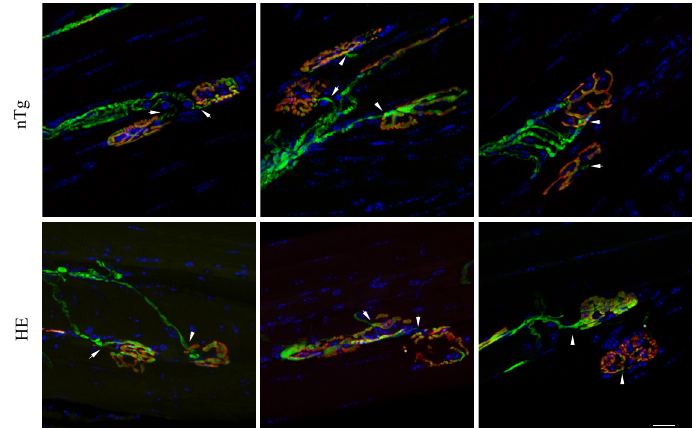
Figure 3. Neuromuscular junctions of HE mice show no evidence of morphological denervation. Representative confocal photographs showing typical EDL neuromuscular junction of 24-month-old HE and nTg mice. Nerve terminals expressing YFP (green) are positioned in close apposition (arrow- head) to the underlying endplate with rhodamine- α BGT-labelled nAChR (red) showing endplates innervation. YFP fluorescence covers endplates of nTg mice unlike HE where the overlap is not systematic (star). Nuclei (blue) are labelled with Hoechst 33342. Scale bar: 20 µ